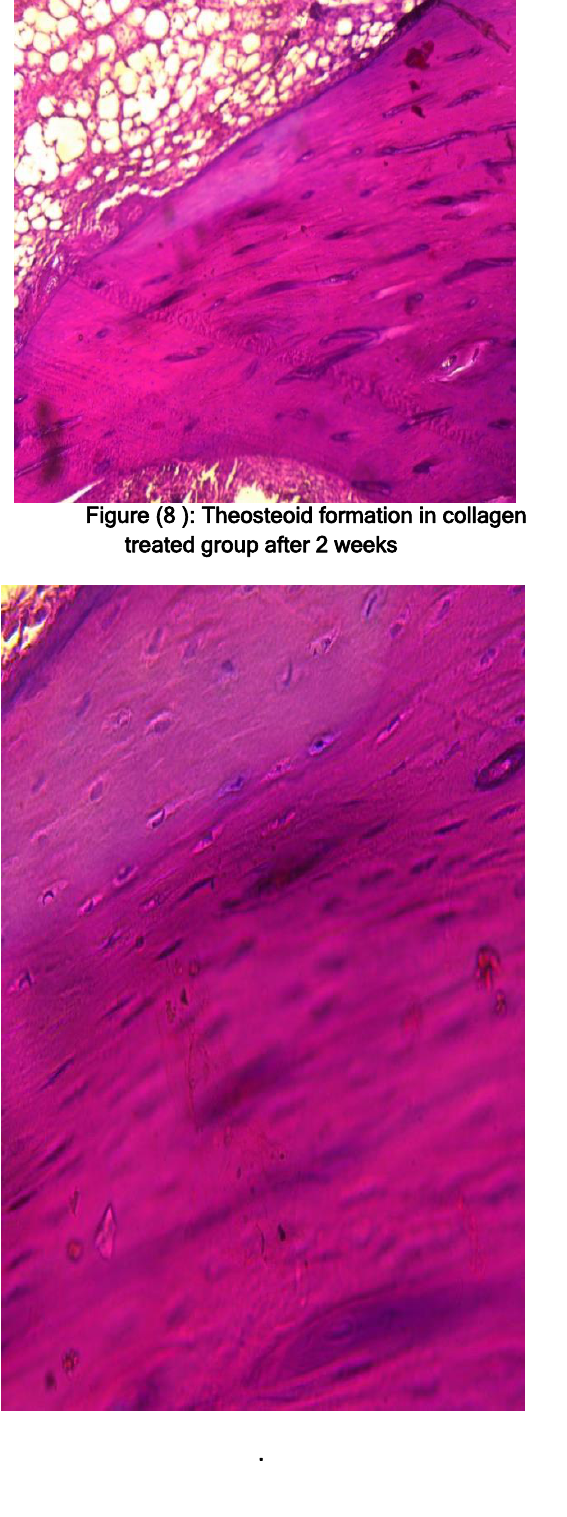
Figure (11): The bone formation in biphasic calcium phosphate bone graft (Osteon II) + collagen (hemospon) group 4 (2